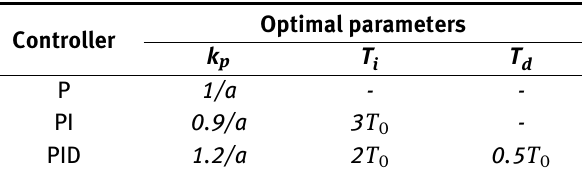
Table 2: The controller tuning parameters according to the Ziegler- Nichols method.